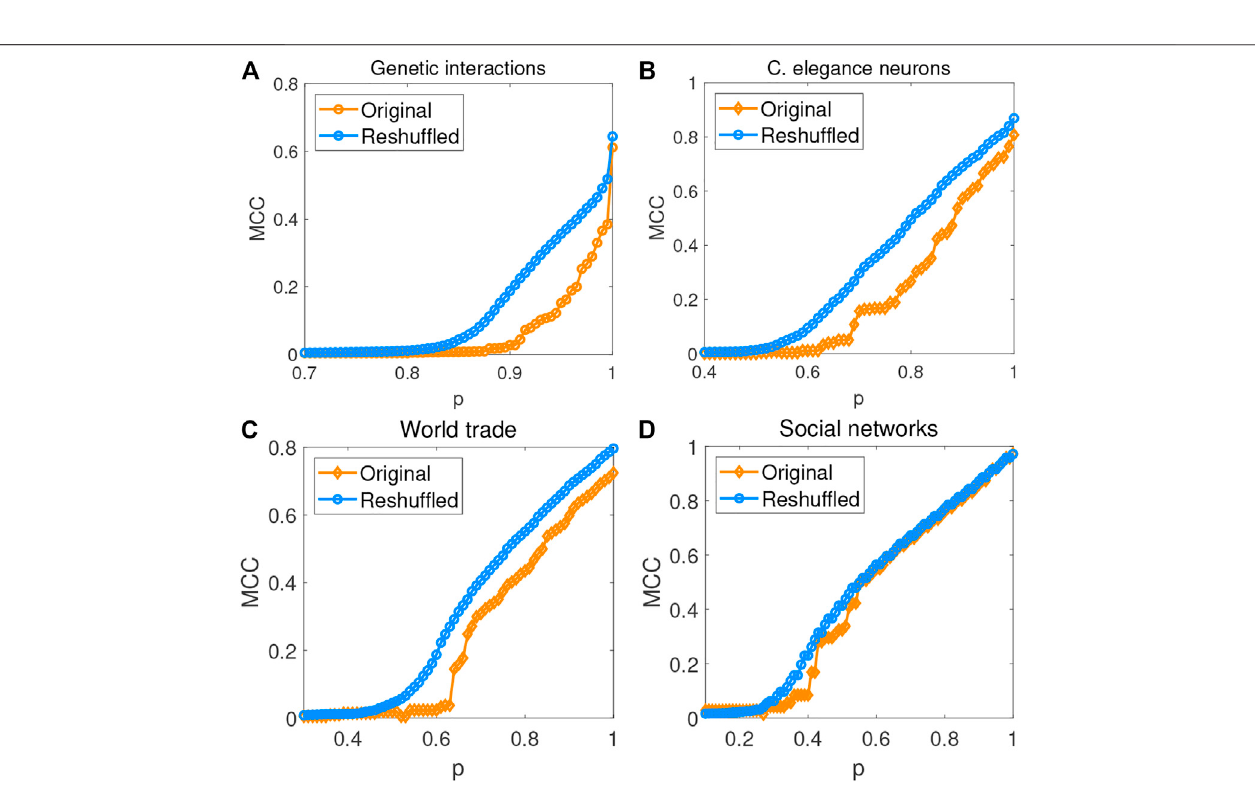
Frontiers in Physics |